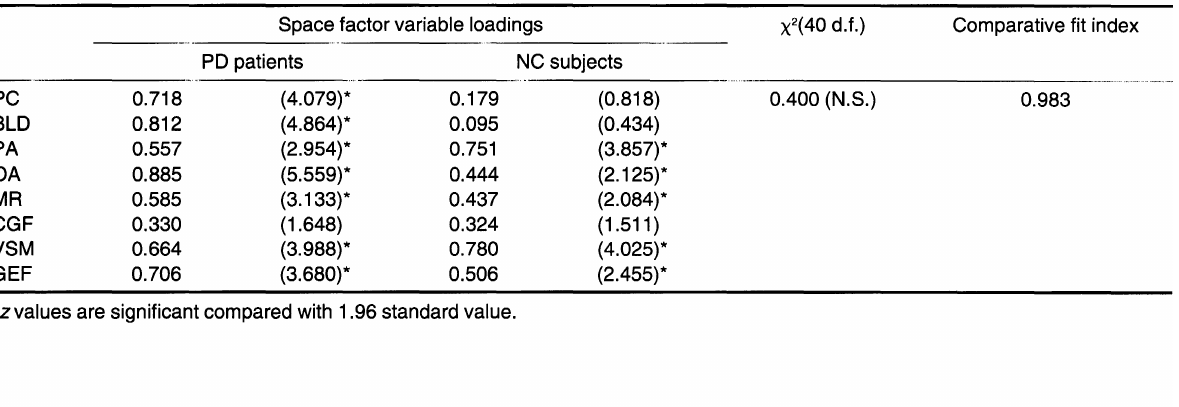
TABLE VIII. Results summary from the confirmatory factor analysis applied on the eight variables in the PO patients and NC subjects